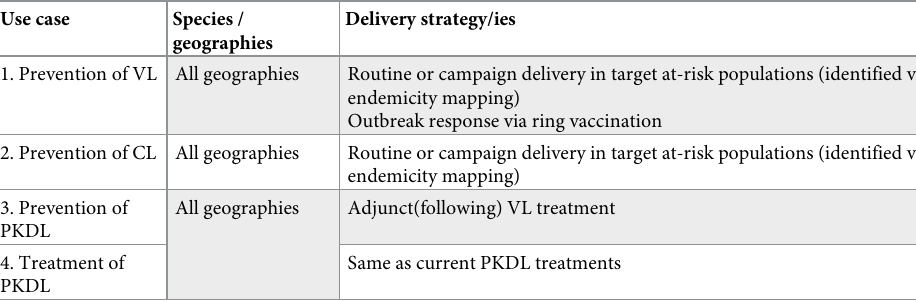
Table 4. Final set of use cases and delivery